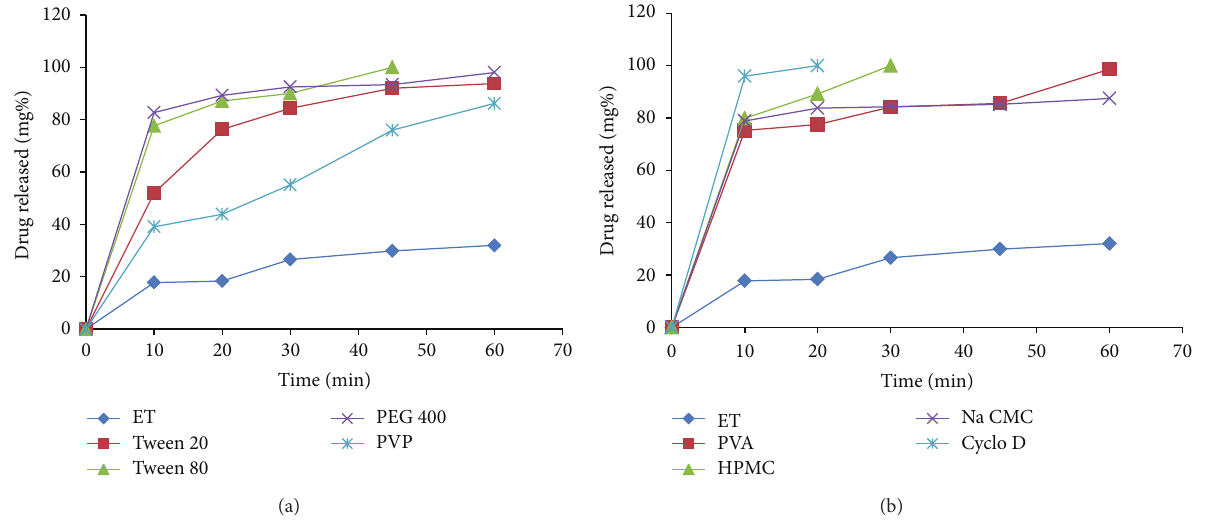
Figure 3: (a) Dissolution profiles of ET nanosuspensions prepared by the pH shift method in distilled water. 𝑃 = 0.03 significant one-way ANOVA. (b) Dissolution profiles of ET nanosuspensions prepared by the pH shift method in distilled water. 𝑃 = 0.024 significant one way